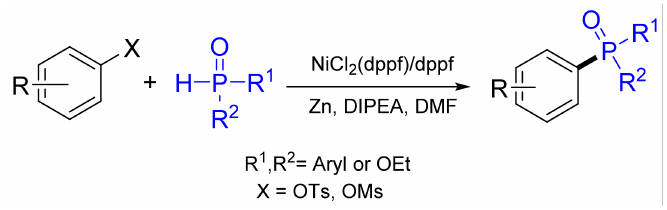
Figure 25. C-P cross-coupling using aryl tosylates or mesylates.